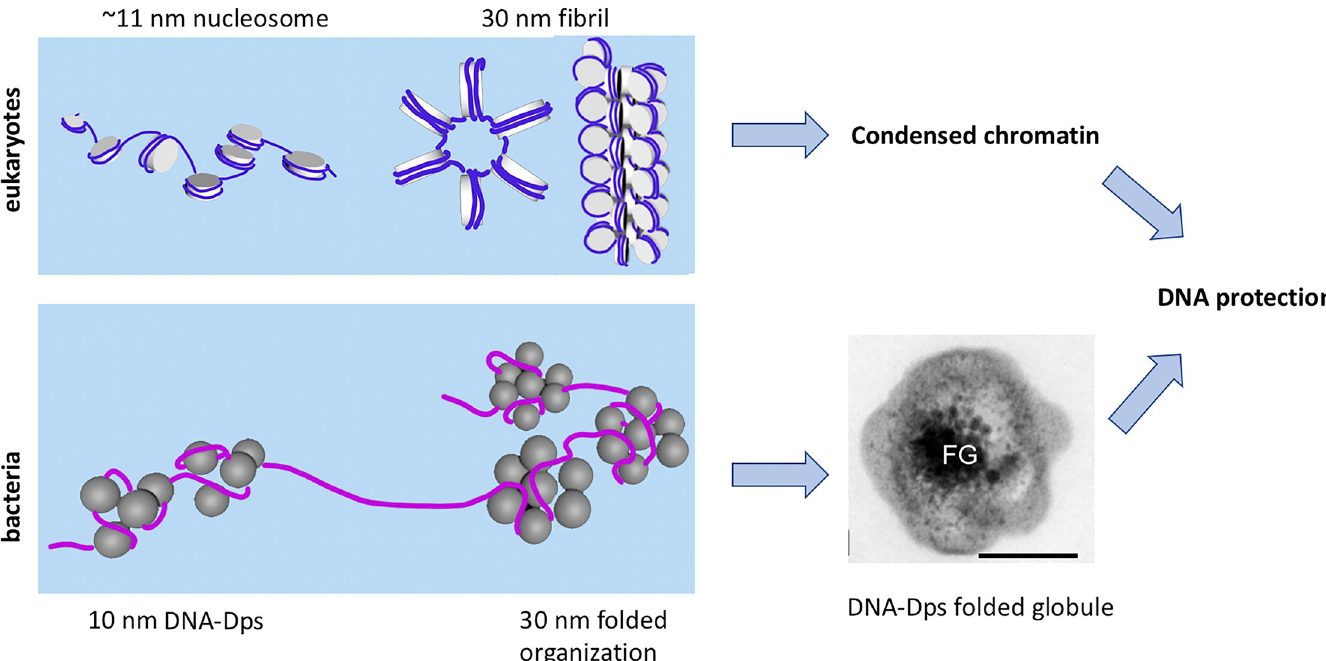
Fig 6. The comparison of pro- and eukaryotic DNA compactization. Top: schematic–eukaryotic nucleosomes (histone proteins wrapped with DNA) fold up into 30 nm fibrils that, in their turn, are compressed to produce fiber and chromosomes, which protect the DNA from external factors. Bottom schematic–prokaryotes do not have defined chromosomes, but the DNA is folded around the Dps molecules to form ‘beads on the string’ first (as in Fig 5D), these could fold into spherical aggregates 30 nm in diameter and, further, into a globule-like structure, which effectively protects the nucleoid DNA from stresses.